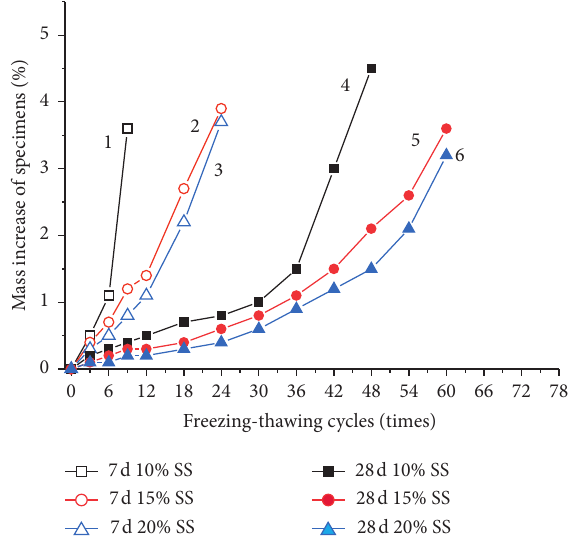
Figure 7: Percentage of mass increase of specimens in Test II (group 5 and 6 specimens were not destroyed completely after 60